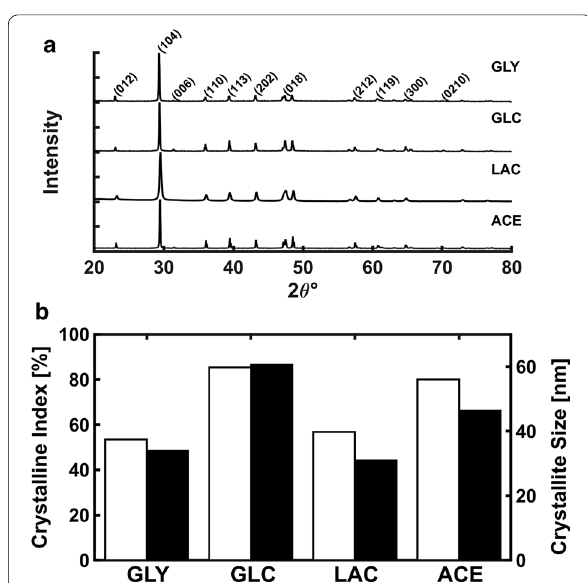
Fig. 3 Crystallographic properties of BCC. Diffractogram a of BCC‑GLY, BCC‑GLC, BCC‑LAC and BCC‑ACE. b Bars show the crystallinity index (white, left scale) and crystallite size of 104 peak (black, right scale) of composites obtained in each